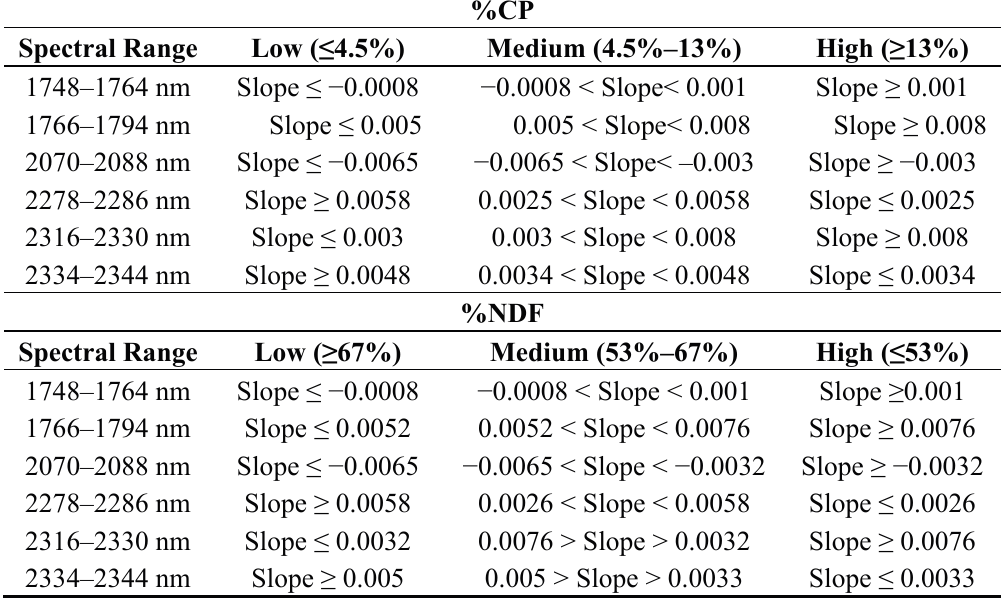
Figure 3. Distribution of CP values for slopes (between 1748–1766 nm) of: ( a ) <0; ( b ) 0–0.001; ( c ) >0.001. Table 1. Slope-based criteria for assessment of pasture quality using three levels of crude protein (CP), neutral detergent fiber (NDF) and metabolic energy concentration